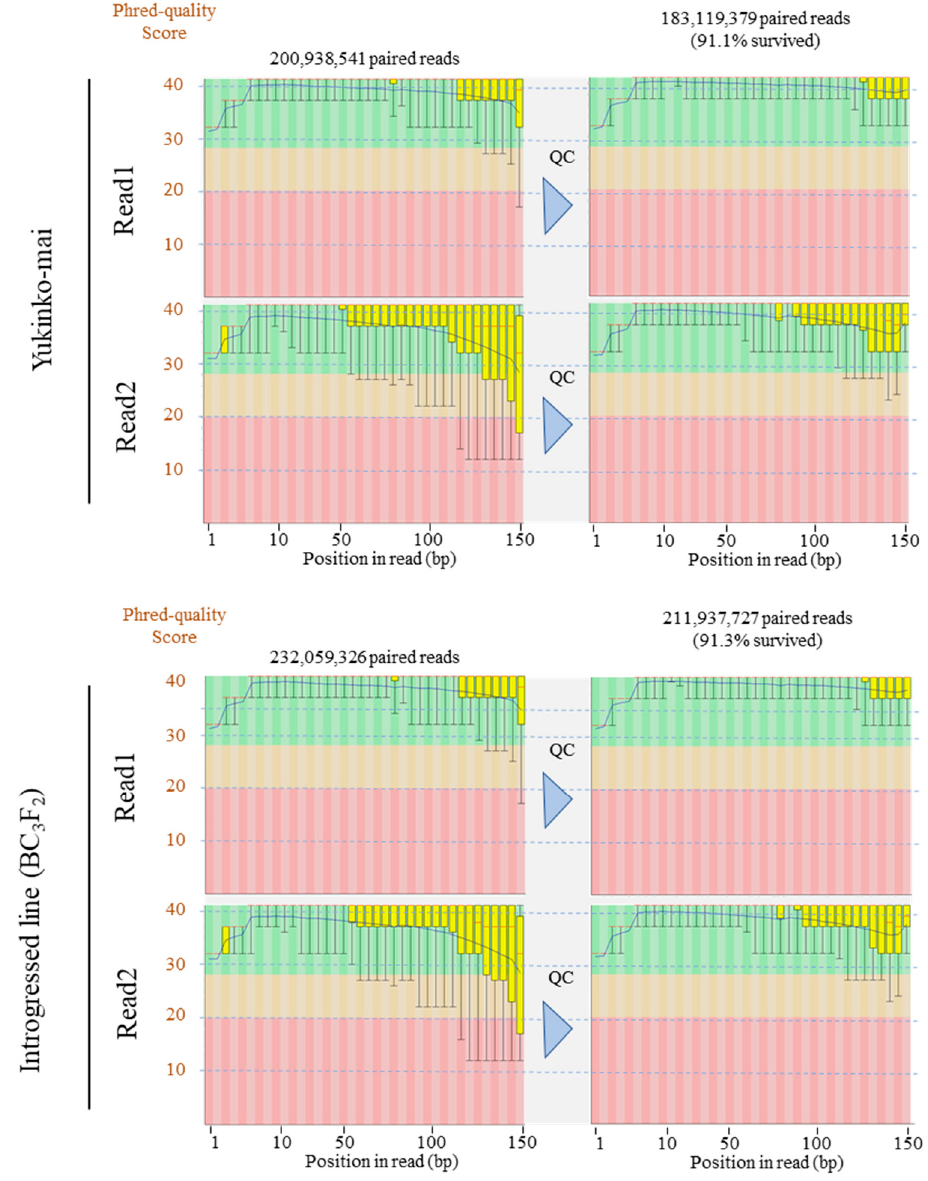
Figure 4. Per base sequence quality of Illumina sequencing reads. Next-generation sequencing (NGS) library was constructed using the gDNA from young leaves of rice ( Oryza sativa L.) plant extracted via optimized NP protocol. Phred quality scores across paired-end reads before ( left columns ) and after ( right columns ) QC are shown in box plots. The blue and red lines represent the mean quality and median value, respectively. The yellow box represents the first quartile and third quartile. The whiskers extend from the ends of the box to the top 10% and 90% values. The background of the graph in the y -axis shows sequence quality. Green, very good quality calls; orange, reasonable quality; red, poor quality. Quality control was performed using Trimmomatic v. 0.33 software [20] with the following parameters: SLIDINGWINDOW: 8:20; TRAILING: 30; MINLEN: 70.